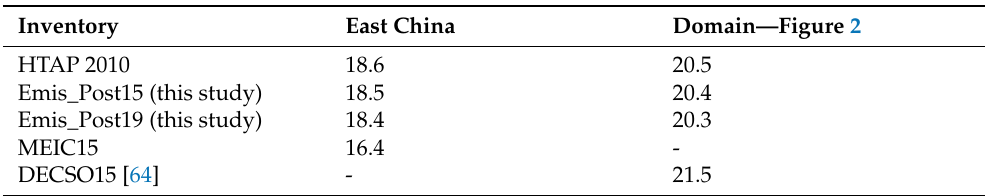
Table 3. The annual NO x emission budget (in Tg) over East China and the entire domain in the Figure 2 with respect to different inventories.